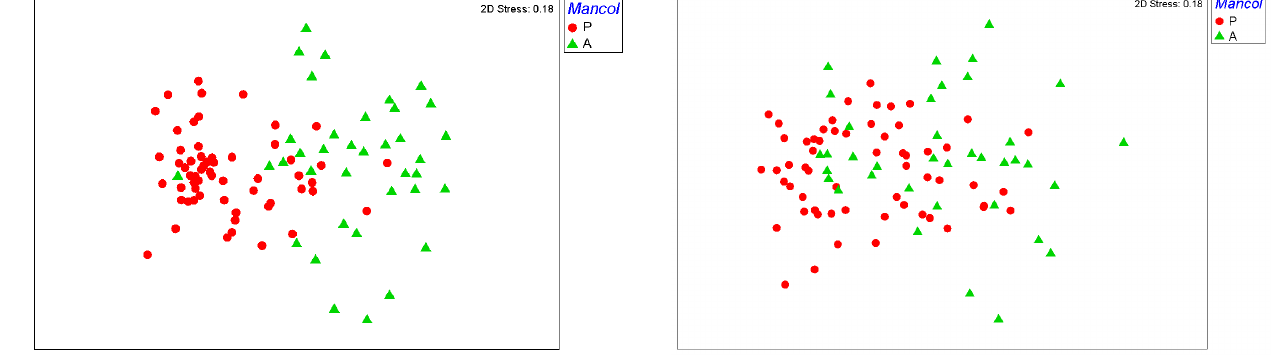
Figure 2. Non-metric multi-dimensional scaling graph pro- duced from Bray Curtis taxonomic similarity of 96 sites using bird, log(x + 1) transformed species density data. Solid red circles are sites colonized by either Manorina species (average density of M. melanocephala or M. flavigula $ 2.5), solid green triangles are sites where colonies are absent. The graph demonstrates a smaller dispersion of sites (taxonomic homogenization) where Manorina colonies are present compared to sites where colonies are absent.